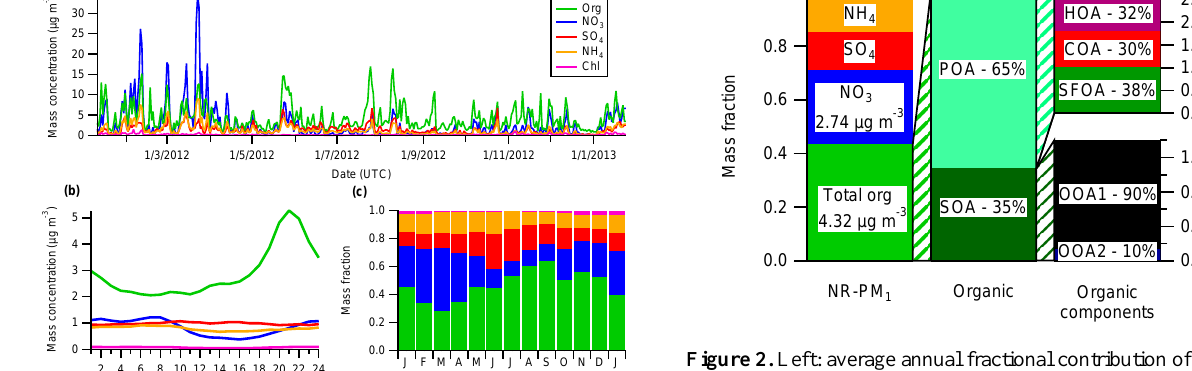
Figure 2. Left: average annual fractional contribution of all species to total NR-PM 1 . The average annual NR-PM 1 concentrations of SO 4 , NH 4 , and Chl were 1.39, 1.30, and 0.15µgm − 3 respectively. Middle: expansion of the organic fraction into its primary and sec- ondary components following PMF analysis. Right top: expansion of the POA fraction into its three components. Right bottom: mag- nification of the SOA fraction showing its two subtypes. SFOA and OOA2 refer to SFOA mod and OOA2 mod respectively. See text in Sect. 4.4 for more details. Note that the organic data plotted in the middle and right bars do not include a period from the summer as discussed in Sect. 4.1 as well as Sects. 4.1 and 4.2 in the Supple-